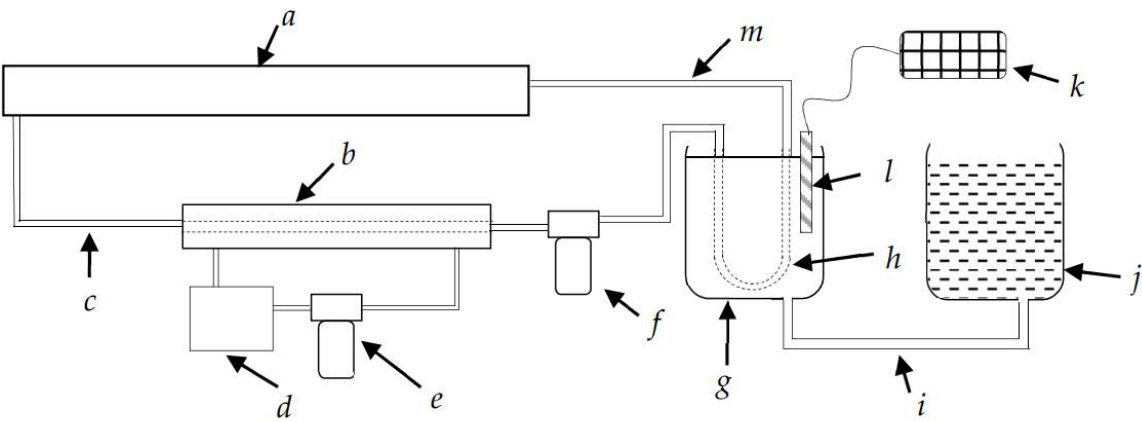
Figure 10. Experimental setup of the laboratory soil gas monitoring test. ( a ) Gas detecting device, ( b ) membrane dryer, ( c ) gas circulation tube, ( d ) silica gel container, ( e ) motor for dryer, ( f ) motor for gas circulation in the system, ( g ) soil container, ( h ) diffusion cell (silicone tube), ( i ) water supply tube, ( j ) water container, ( k ) data logger, ( l ) soil moisture probe, ( m ) gas circulation